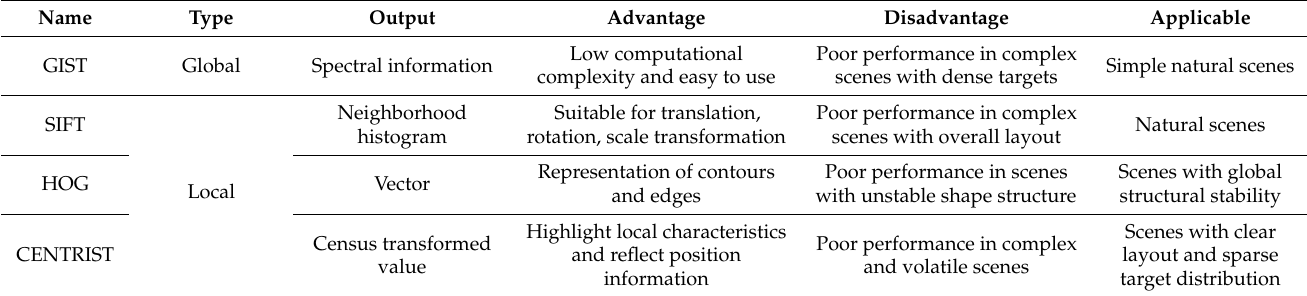
Table 2. Comparison of main methods in visual